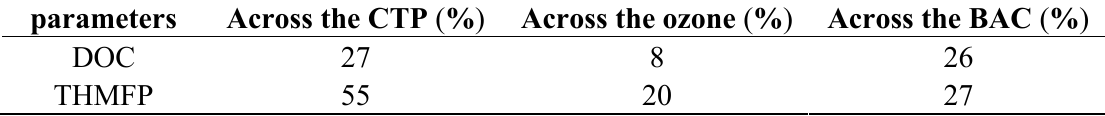
Table 3. Percentage removal of the DOC and THMFP across treatment processes (the removal efficiencies of the DOC and THMFP were compared to the previous treatment